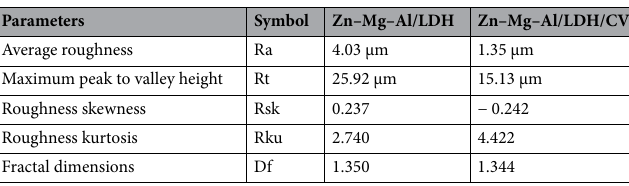
Table 1. The roughness parameters of prepared LDH before and after